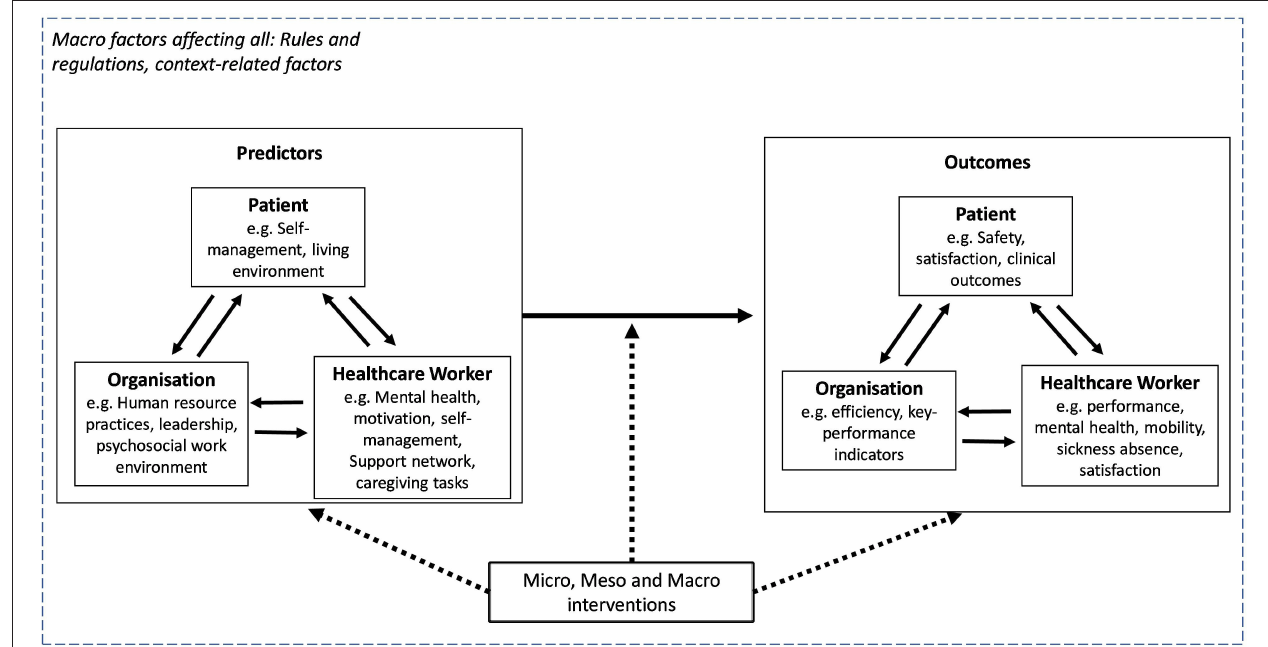
FIGURE 1 | Possible research pathways Healthy Healthcare: factors at micro-, meso-, and macrolevel.